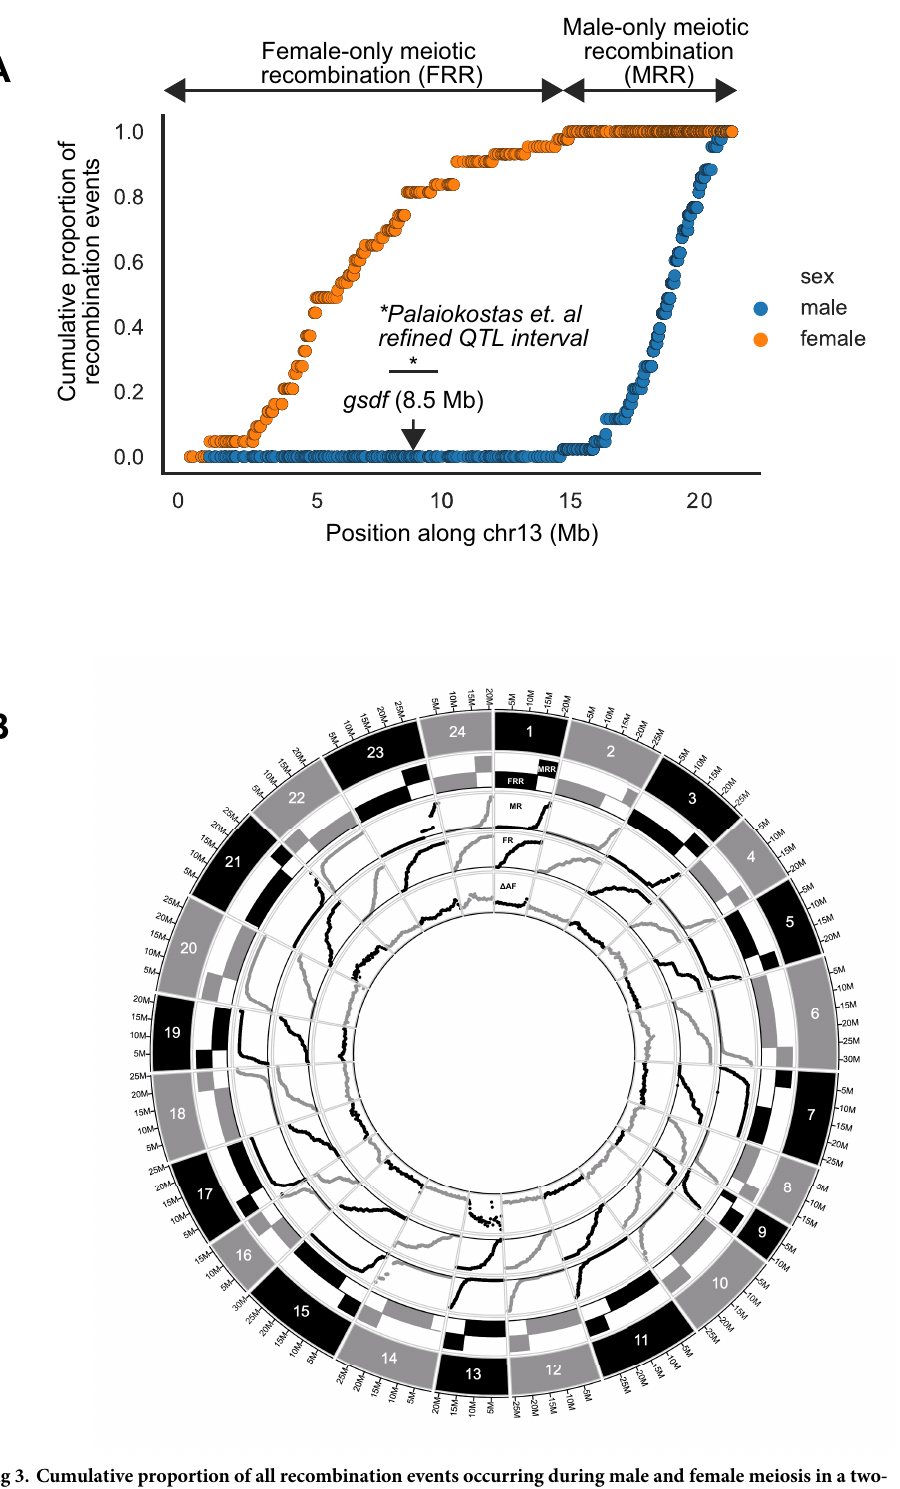
Fig 3. Cumulative proportion of all recombination events occurring during male and female meiosis in a two- pedigree intercross. A chr13 with gsdf location indicated. � Mapping interval of markers most highly associated with sex in a previous study [19]. B Male and female linkage maps differ strongly genome-wide. The outermost track visualizes individual chromosomes. Locations of defined Male-only and Female-only meiotic Recombination Regions (MRRs and FRRs) are shown as alternating black/grey rectangular tracks beneath each chromosome. All